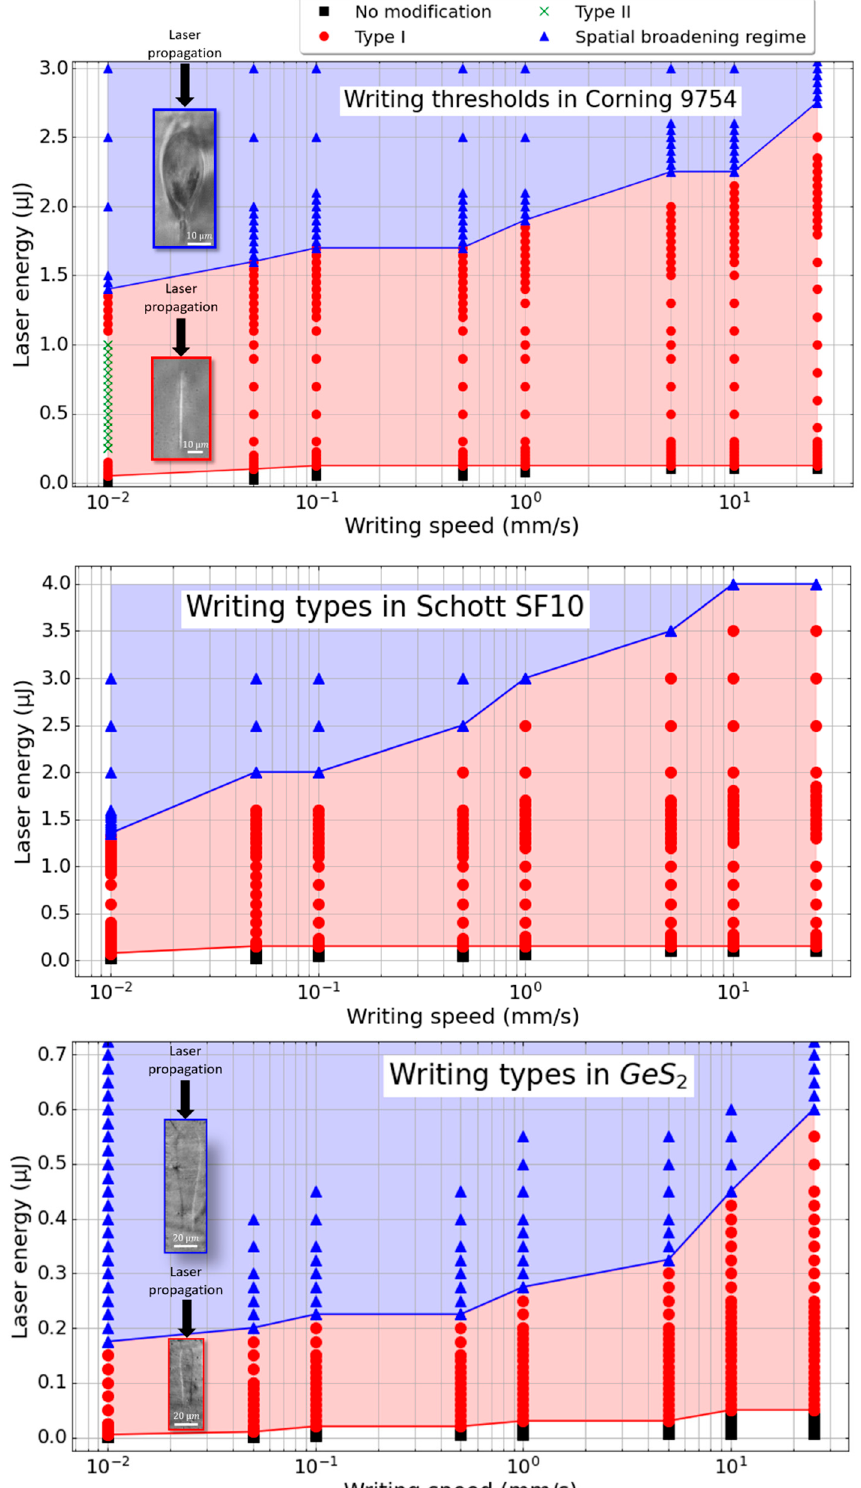
Figure 1. On the top, processing windows in the Corning 9754. In the middle, processing windows in the Schott SF10. On the bottom, processing windows in the GeS 2 glass. In the blue areas, images of a spatial broadening regime profiles (criterion: a 20% increase in laser track width compared to the beam waist). In the red areas, images of Type I profiles. Laser parameters: 1030 nm, 800 fs, 100 kHz, 0.6 NA, and linear polarization along X.